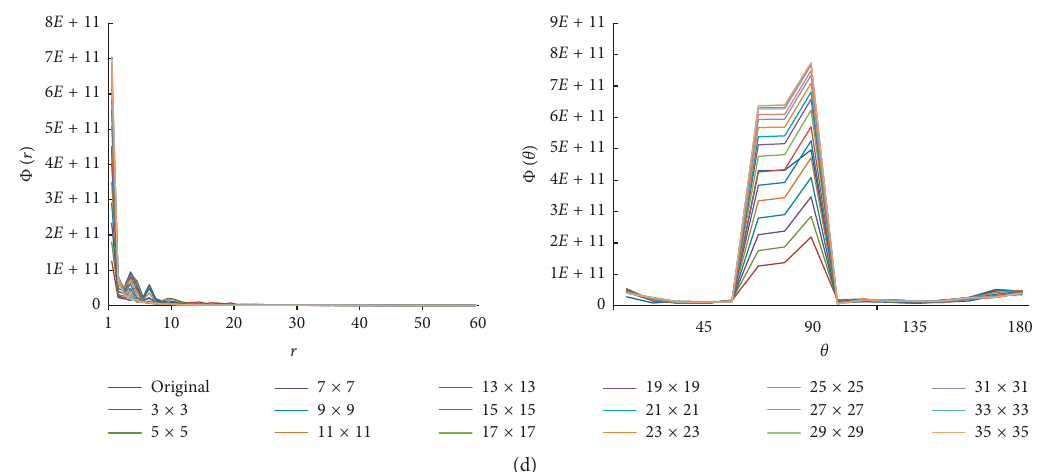
Figure 6: Radius distribution and angular distribution curves of four subset textures at different scales. Angular and radial spectrum curves of (a) houses, (b) farmland_1, (c) farmland_2, and (d) mixed